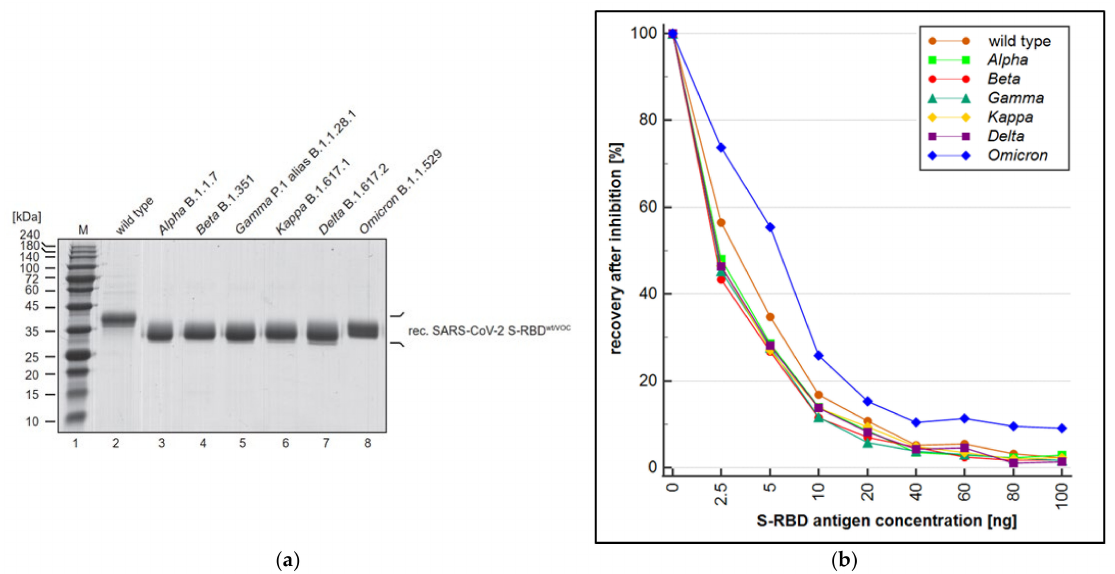
Figure 4. ( a ) Quantity and purity of the recombinant S-RBD fragment of SARS-CoV-2 wild type (lane 2), Alpha B.1.1.7 (lane 3), Beta B.1.351 (lane 4), Gamma P.1 alias B.1.1.28.1 (lane 5), Kappa B.1.617.1